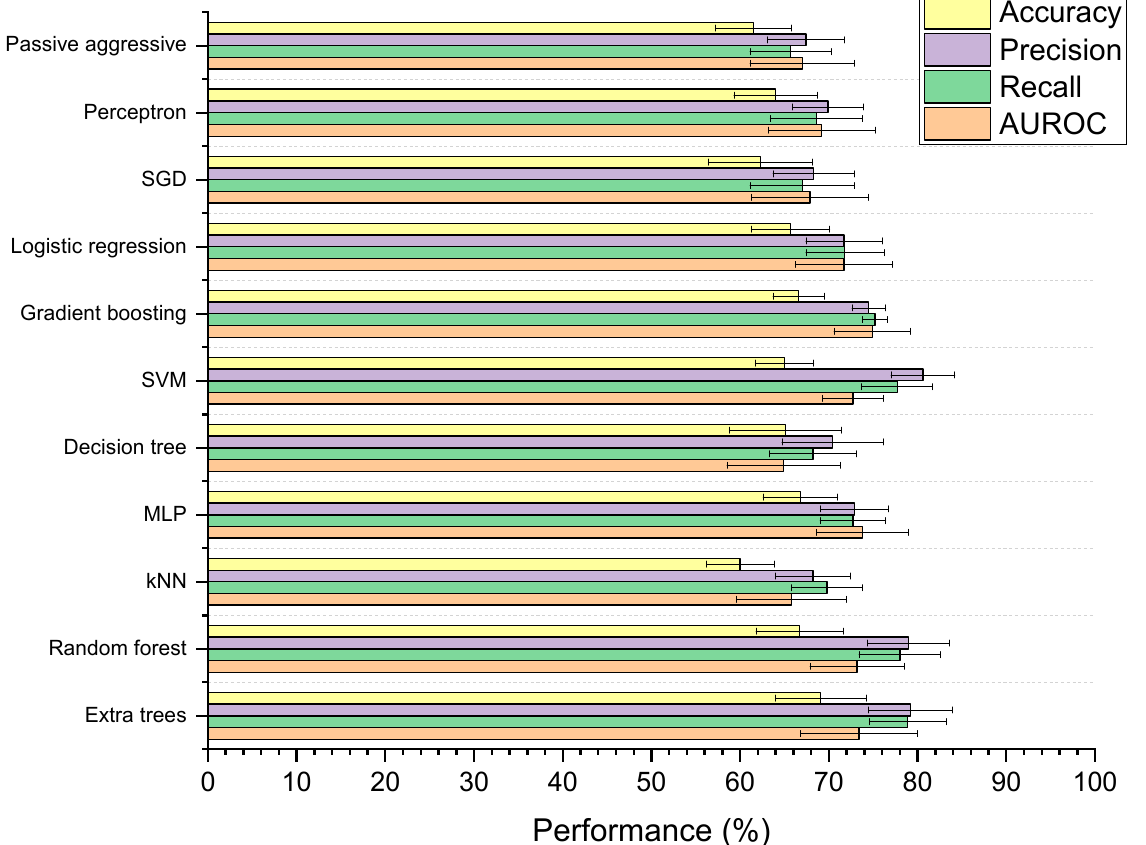
Figure 5. Performance of machine learning (ML) models designed to classify drugs as either susceptible or not susceptible to depletion by gut microbiota. Accuracy is balanced, and precision and recall are weighted. The 11 ML techniques were: extra trees, random forest, K-nearest neighbours (kNN), multilayer perceptron (MLP), decision tree, support vector machine (SVM), gradient boosting, logistic regression, stochastic gradient descent (SGD), perceptron, and passive aggressive classification.